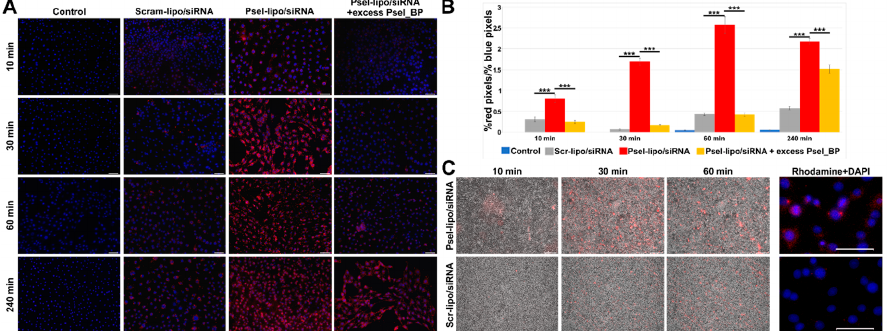
Figure 5. ( A ) Uptake of Rhodamine B-labelled Psel-lipo/siRNA and Scr-lipo/siRNA lipoplexes (charge ratio R +/ − = 4; 20 nM siRNA) by TNF- α activated bEnd.3 cells in the absence or the presence of excess of P-selectin binding peptide (Psel_BP), observed by fluorescence microscopy, at different time interval in static conditions of incubation [lipoplexes ( red ) and cell nuclei ( blue ); bar 50 µ m]. ( B ) Quantification of lipoplexes uptake by the cells in static conditions expressed as ratio of red pixels percentage to blue pixels percentage for each image field (each point represent media of 9 fields). Bar graph shows data as mean ± S.E.M. *** p < 0.0001. ( C ) Time-lapse observation of dynamic interaction between Rhodamine B-labelled lipoplexes (Psel-lipo/siRNA and Scr-lipo/siRNA) and bEnd.3 cells in FCS2 system using an inverted fluorescence microscope. Overlay of phase contrast and lipoplexes fluorescence images ( red ) is presented (bar 200 µ m) and of lipoplexes fluorescence (Rhodamine-PE; red ) and nuclei fluorescence (DAPI; blue ) (bar 50 µ